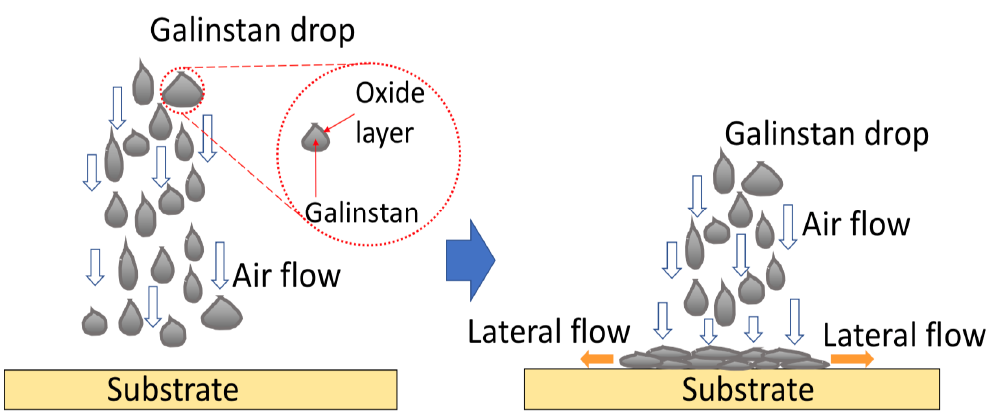
Figure 1. Schematic illustration of liquid metal (LM) spraying process.